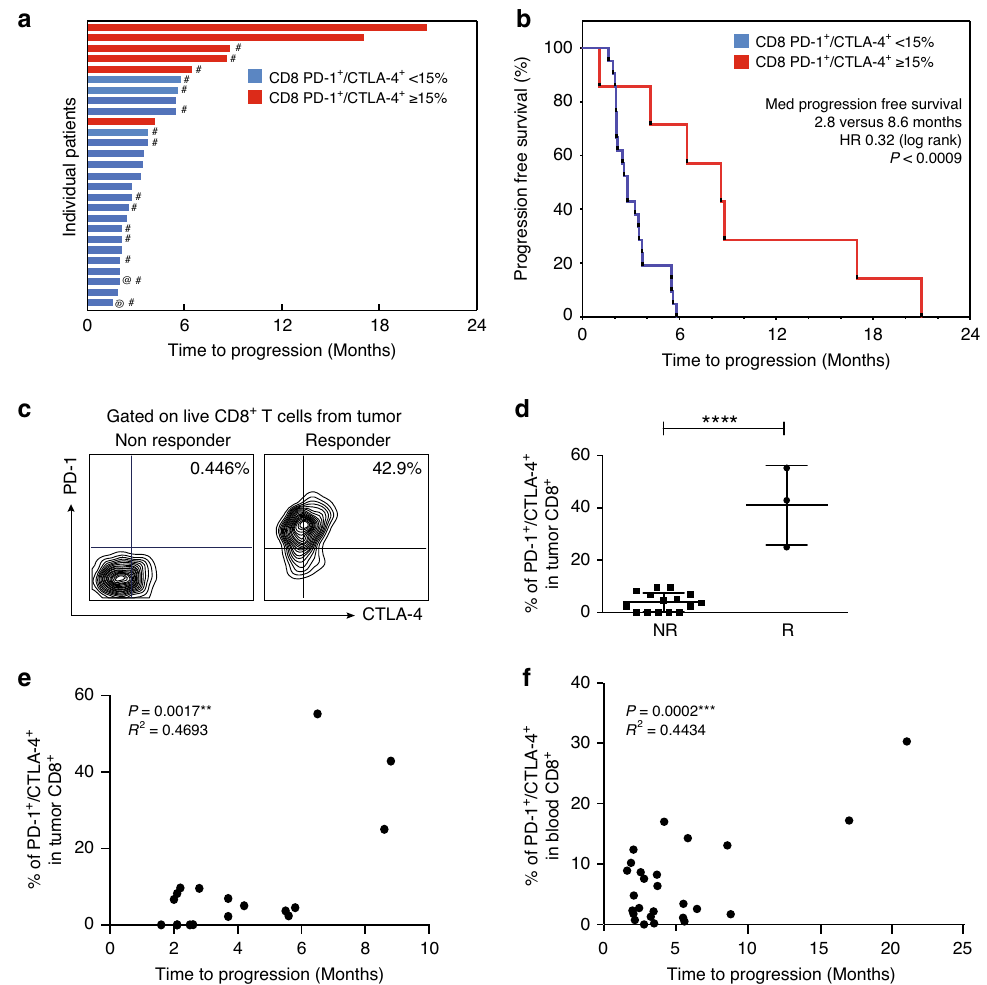
Fig. 2 Exhausted CD-8 T cells predict response to anti-PD-1 therapy. a Time to progression in months for the patients ’ cohort ( n = 27). b Median progression free survival for the patients ’ cohort. Hashtag (#) indicates tumor specimens available in the analysis; at sign (@) indicates the patient with PD-L1 staining >1%. Patients with PD-1 + CTLA-4 + CD8 + T-cells expression [in metastatic tumor sites as hashtag (#), or blood, quanti fi ed by fl ow cytometry] >15% are shown in red, while those with % <15 are shown in blue. c Representative fl ow cytometry plots for PD-1 + CTLA-4 + live CD8 + T-cells in tumor in patients who bene fi t (Responder) or not (Non responder) from therapy. d Flow cytometry quanti fi cation of PD-1 + CTLA-4 + CD8 + T-cells in non-responders ( NR) versus responders (R). Data are presented as the mean ± SD ( n = 18). Statistical signi fi cance is indicated by p -values as * p ≤ 0.05; ** p ≤ 0.01; **** p ≤ 0.0001; NS = not signi fi cant and was determined by unpaired two-tailed T test. Correlation of quanti fi cation of PD-1 + CTLA-4 + CD8 + T- cells from metastatic tumors ( e ) and blood ( f ) with time to progression in months. Two-tailed Pearson correlation test was performed with p -value = 0.0017 and p -value = 0,0002 for E and F